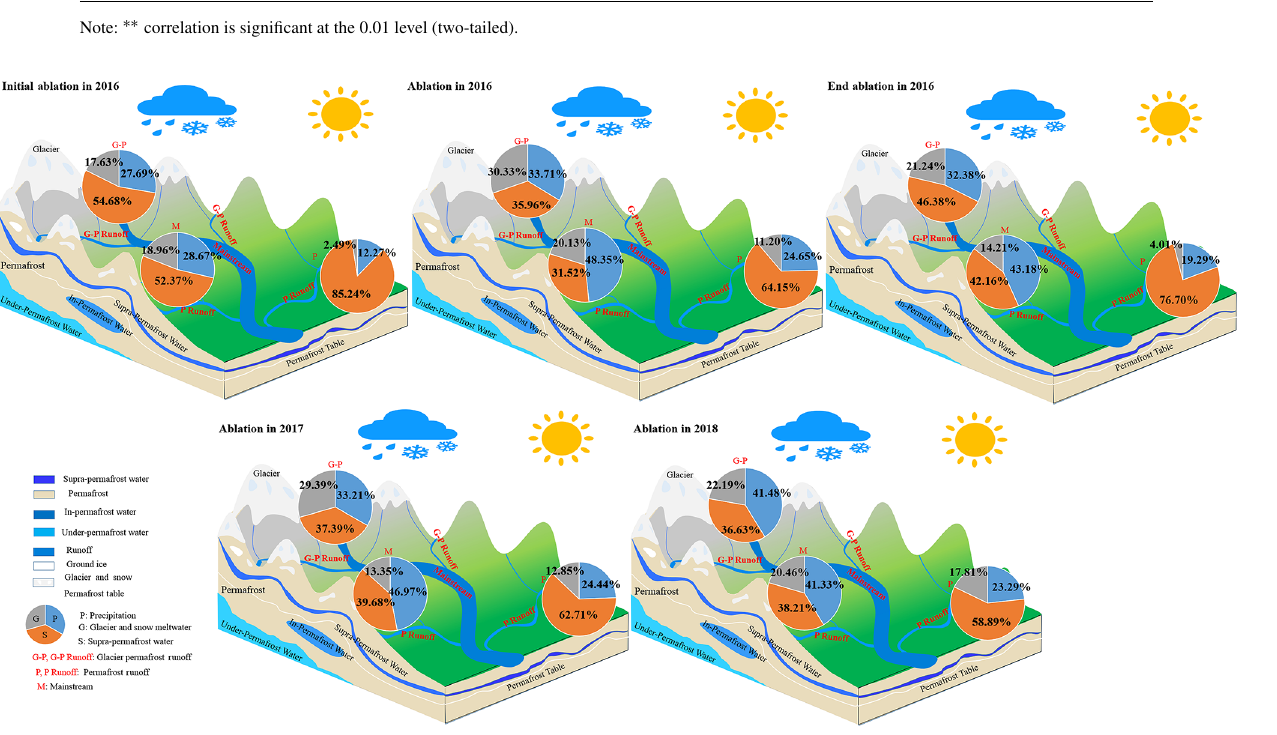
were 18.96 %, 20.13 %, 14.21 %, 13.35 %, and 20.46 %,